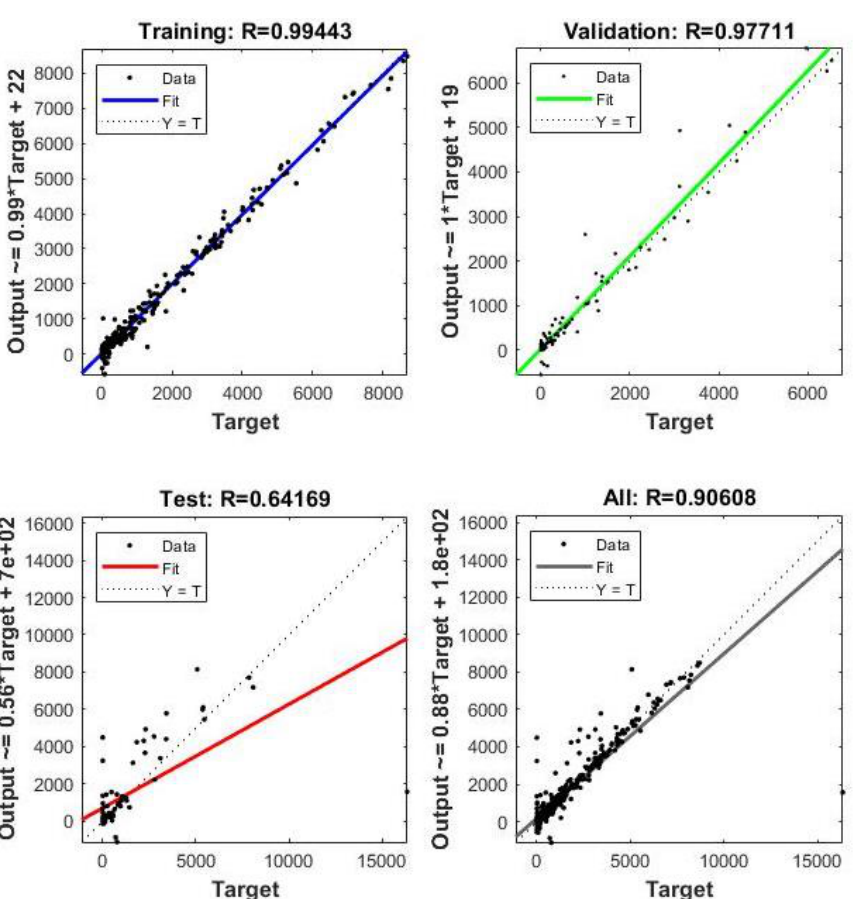
Figure 7. Best fitting for training, validation, testing, and all observed